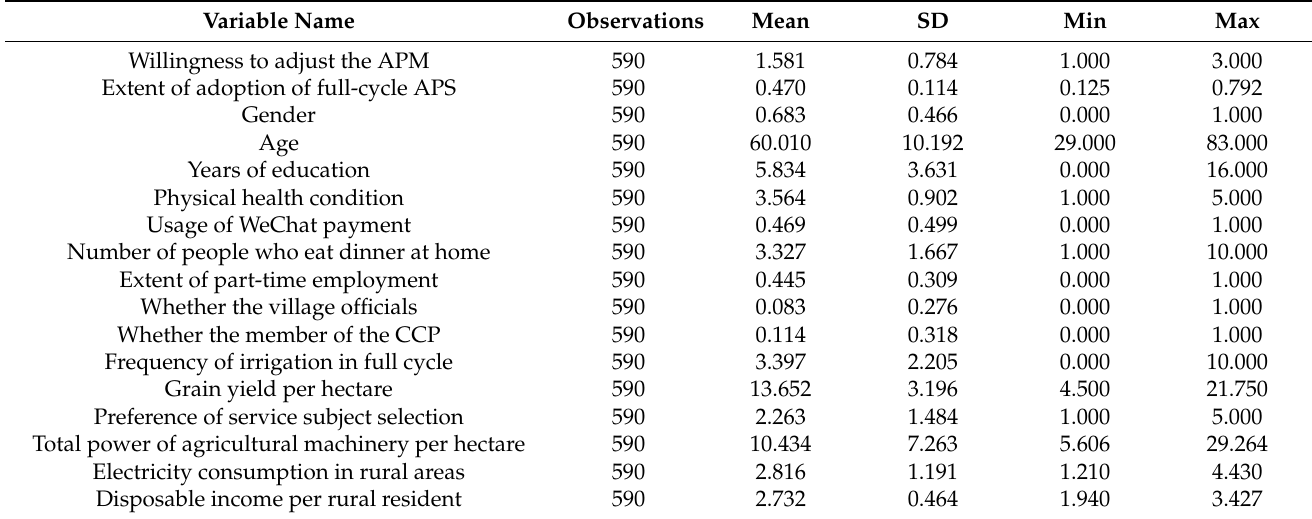
Table 2. Descriptive statistical analysis of the main